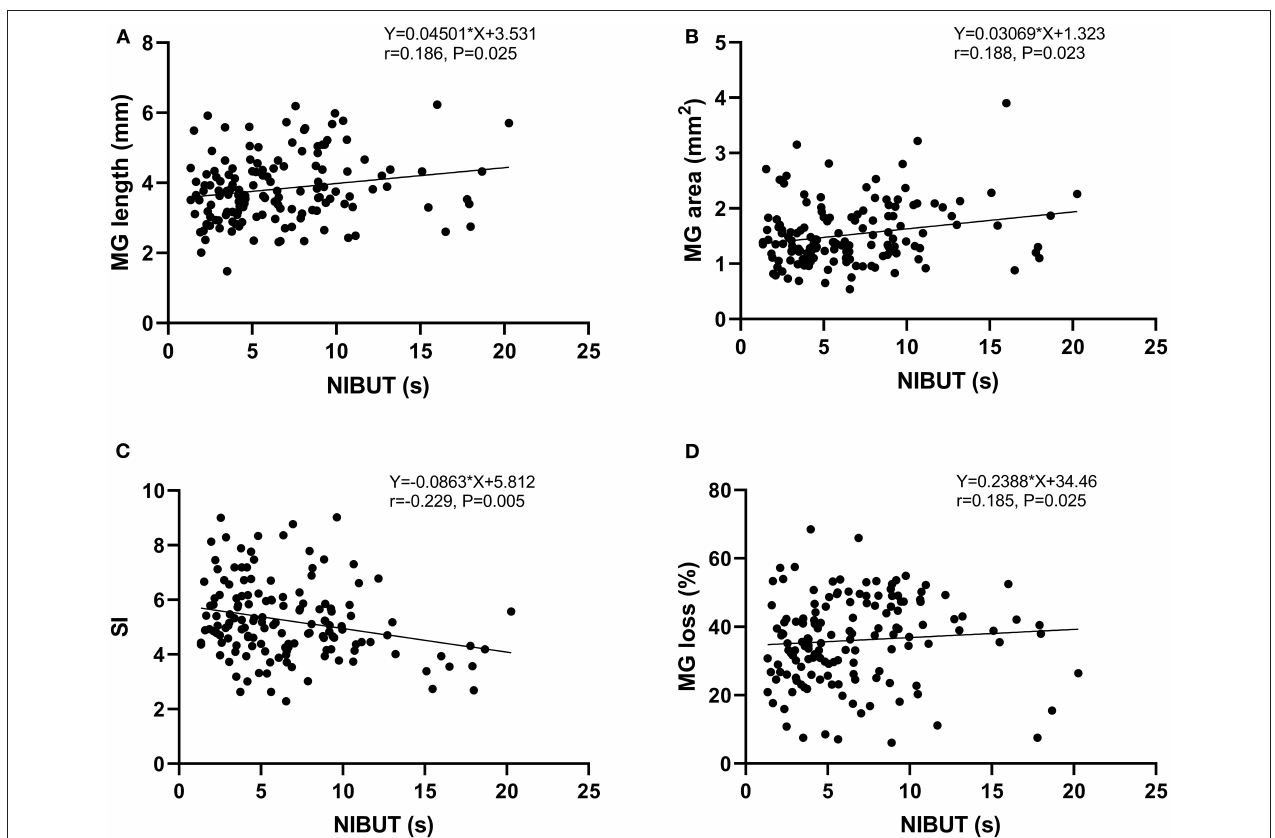
FIGURE 5 | Analysis of the Spearman’s rank correlation between the NIBUT and MG length (A) , MG area (B) , SI (C) , and MG loss (D)